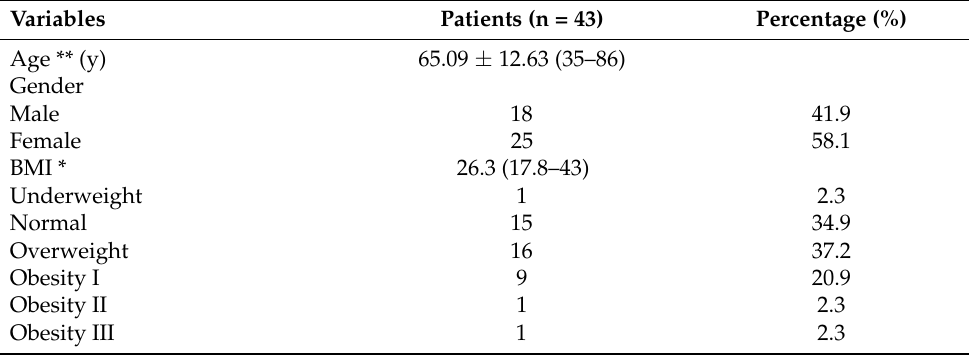
Table 1. Patient demographics, clinical characteristics and surgical